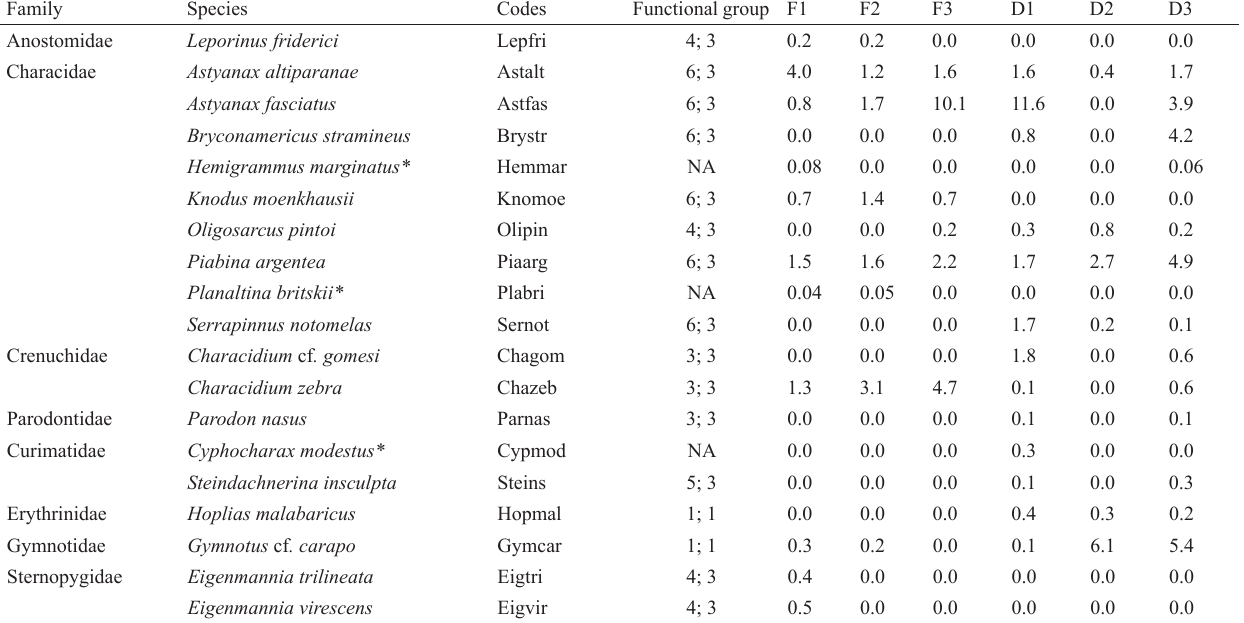
Table 2. Mean abundance of species across sections in the forested (F1 to F3) and deforested (D1 to D3) streams in the rio São José dos Dourados basin, Upper Paraná and their respective functional group memberships for the partition #30 and #33, respectively. * species that occurred in less than 3% of the sections. NA species not assigned to a group. # invasive